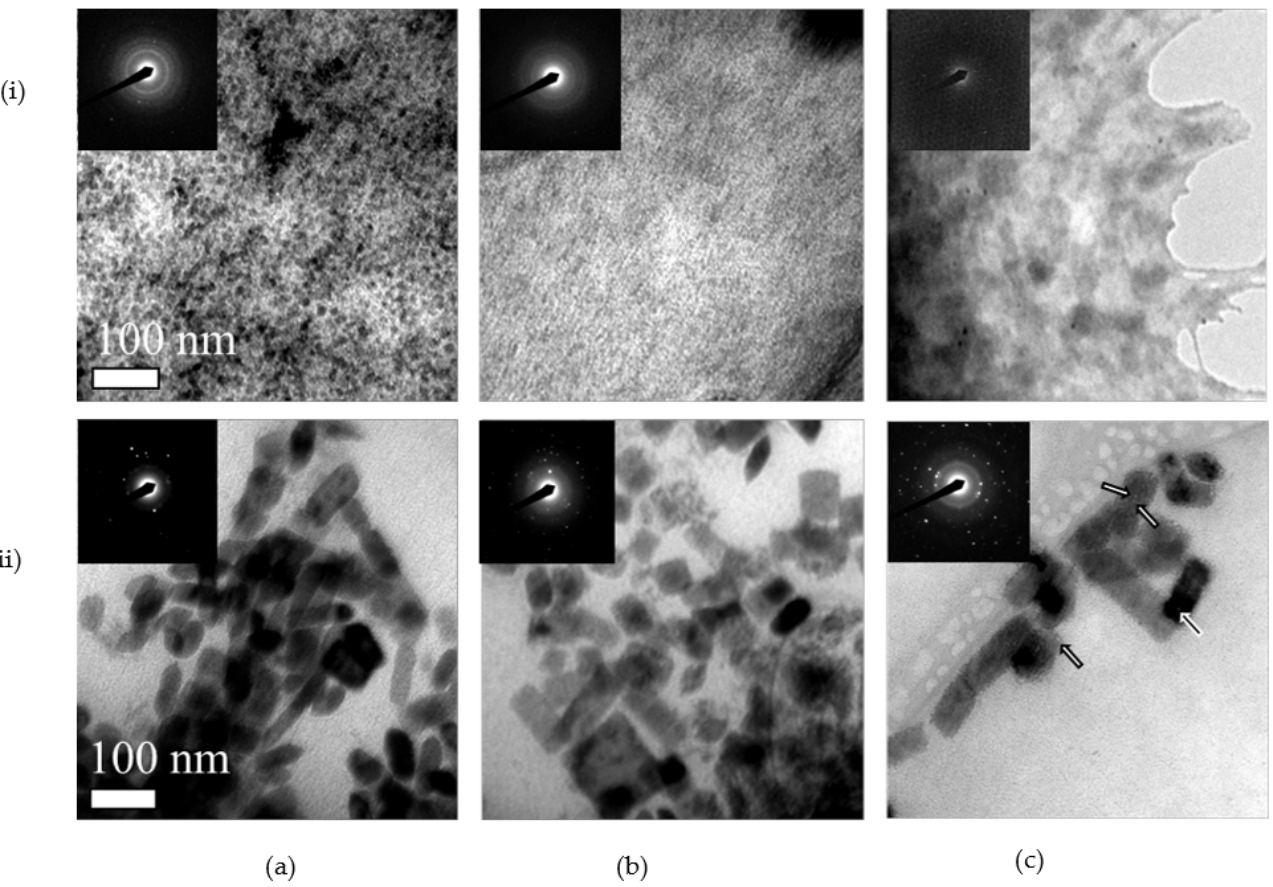
Figure 8. TEM images and SAED patterns of ( i ) CeO x and ( ii ) Eu:CeO x nanoparticles generated from ON preparation route during ion irradiation: ( a ) green, ( b ) 1 × 10 13 cm − 2 , and ( c ) 1 × 10 15 cm − 2 . Respective SAED patterns are displayed in the inset of each micrograph. Scale bars are 100 nm in all micrographs.